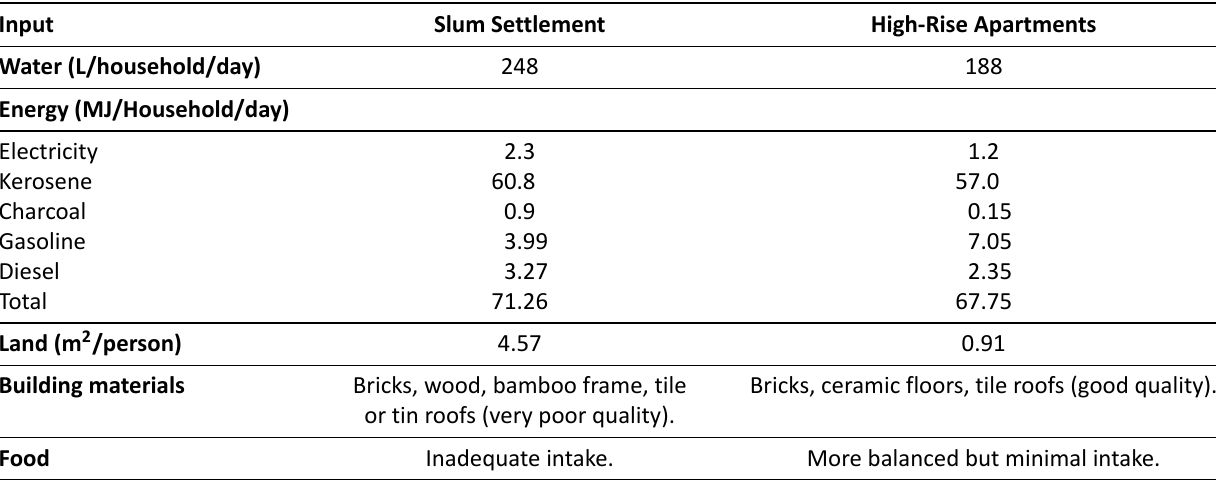
Table 1. Resource inputs to Ciliwung River slum settlement and high-rise apartments, Jakarta, Indonesia. Source: Arief (1998).